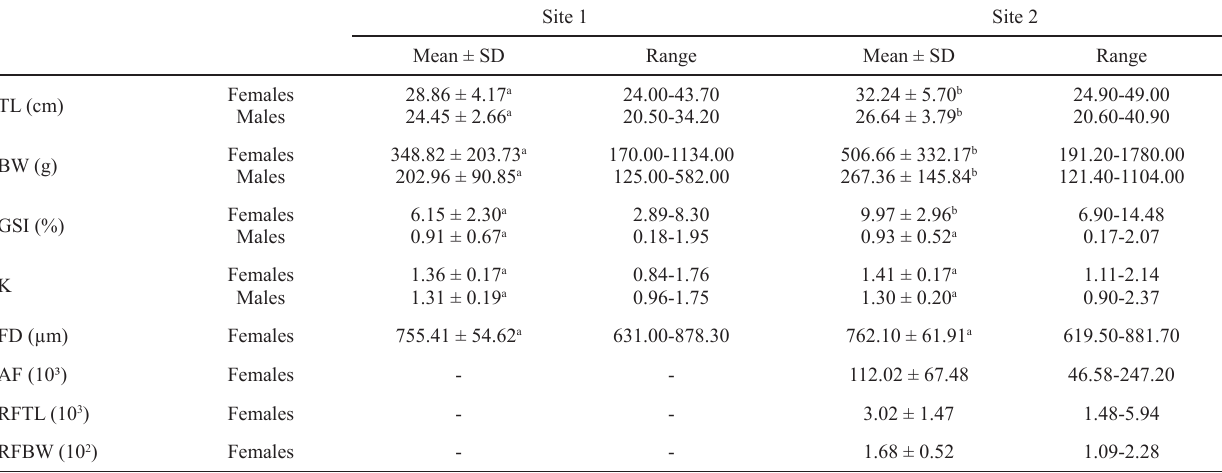
Table 1. Biological variables of Brycon orthotaenia females and males captured in two sites of upper rio São Francisco, downstream from the Três Marias Dam. Site 1: Immediately downstream from the Três Marias Dam; Site 2: in the confluence with the rio Abaeté; total length ( TL ), body weight ( BW ), gonadosomatic index for mature females (GSI), Fulton condition factor (K), follicular diameter (FD), absolute fecundity ( AF ), relative fecundity total length ( RFTL ), relative fecundity body weight ( RFBW ); data are expressed as mean ± standard deviation (SD); different superscripts with means in each sex indicate differences between river sections (P <